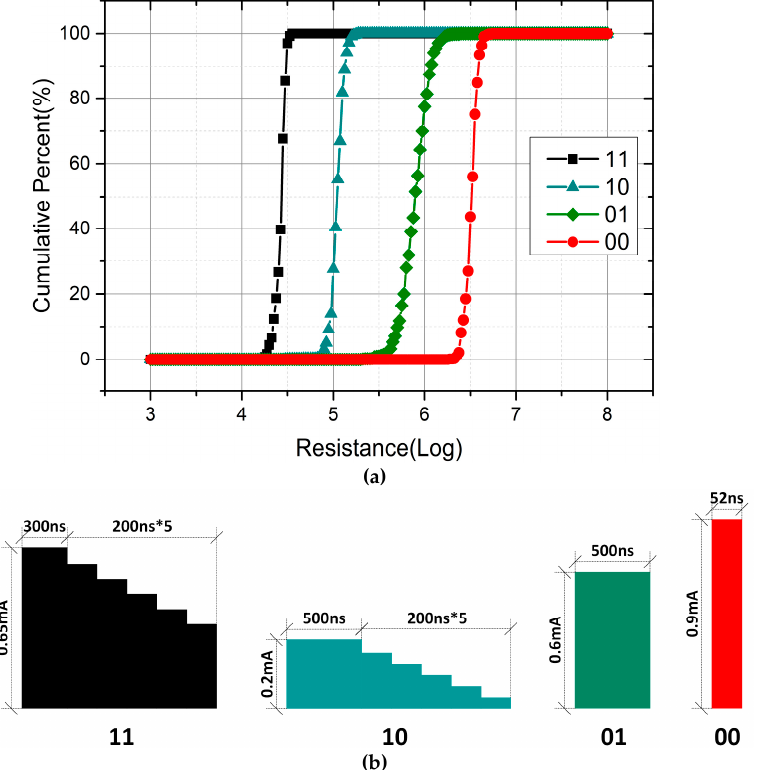
Figure 10. ( a ) Resistance distribution of four states in phase change memory (PCM) cells with a ramp- down current pulse scheme; ( b ) the corresponding program pulses. ramp-down current pulse scheme; ( b ) the corresponding program